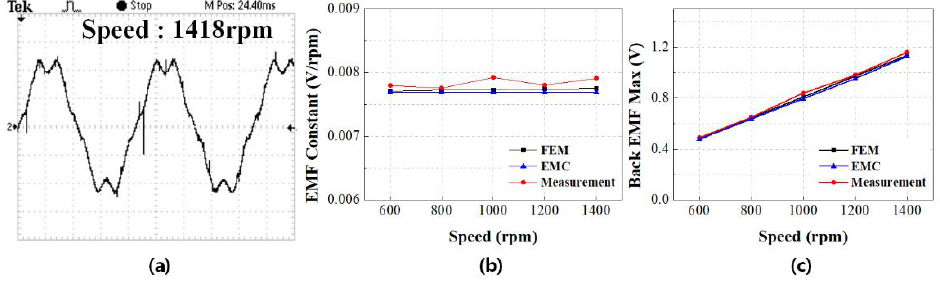
Figure 11. The results of the back-EMF measurement. ( a ) experiment result, ( b ) back-EMF constant, and ( c ) back-EMF max value result.